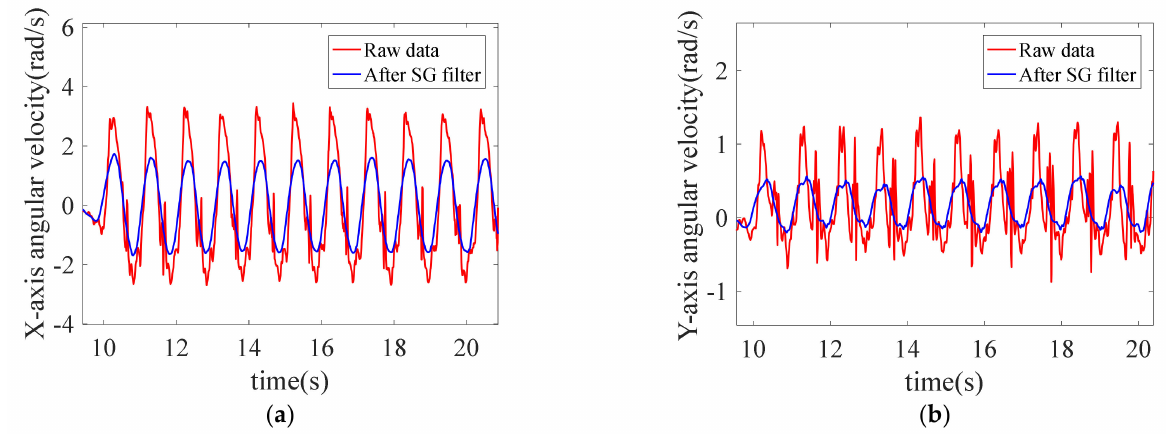
Figure 13. Comparison diagrams before and after SG filter: ( a ) X -axis angular velocity before and after SG filter; and ( b ) Y -axis angular velocity before and after SG filter.